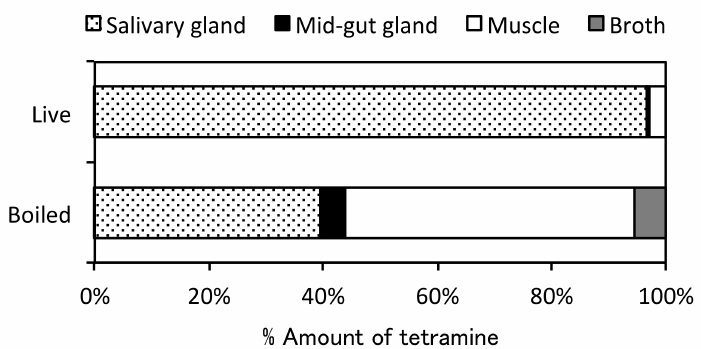
Figure 5. Tetramine contents in the tissues (salivary gland, mid-gut gland, and muscle) of live and boiled specimens of Neptunea polycostata . Drawn from the data in Tables 1 and 2 in the paper of Kawashima et al. [46]. A group of three live specimens was analyzed for tetramine in the salivary gland, mid-gut gland, and muscle. Another group of three live specimens with shells was heated in boiling water for 15 min and analyzed for tetramine in the salivary gland, mid-gut gland, muscle, and broth. Data are expressed as the mean of three